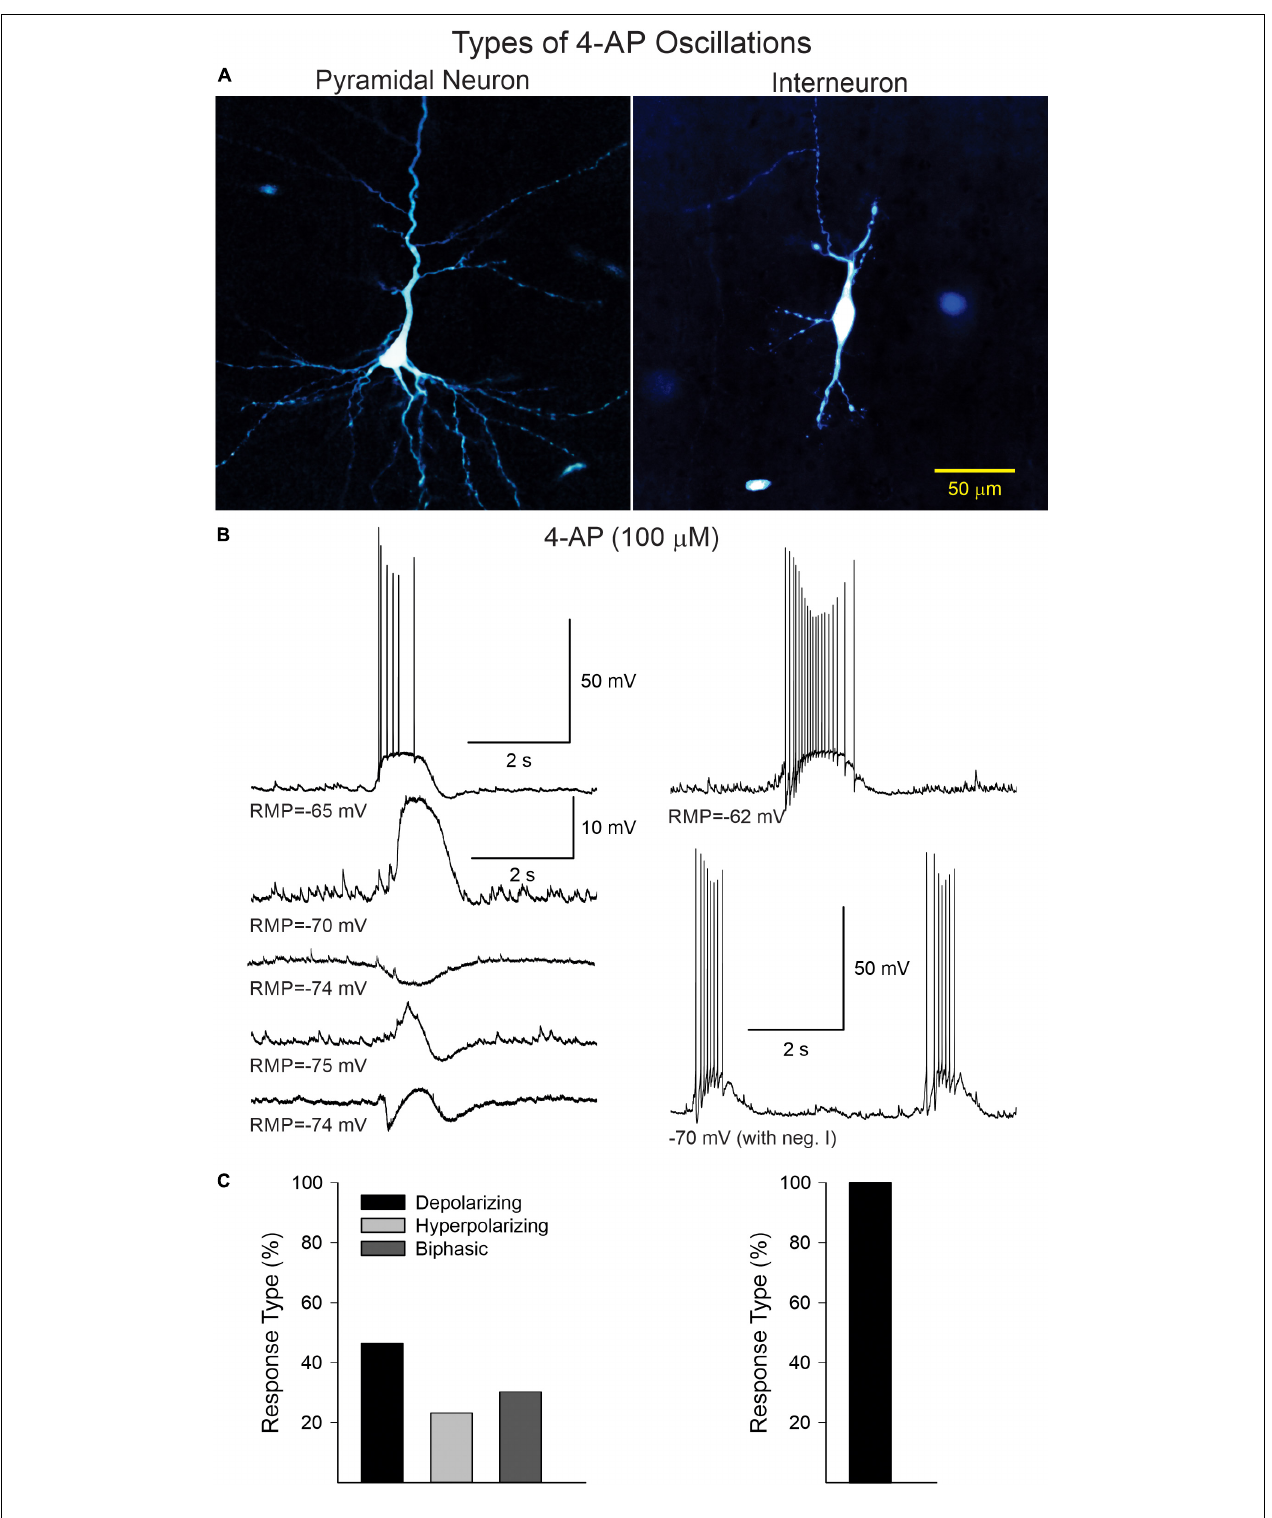
FIGURE 2 | (A) Examples of a CPN and an interneuron recorded and filled with biocytin. (B) Current clamp recordings illustrating the different types of 4-AP oscillations in CPNs and interneurons. In CPNs, 4-AP induced three main types of oscillations; most were depolarizing, with or without action potentials, some were mainly hyperpolarizing, and others were biphasic (depolarization followed by hyperpolarization or vice versa). In interneurons, 4-AP consistently induced membrane depolarizations accompanied by bursts of action potentials, even at hyperpolarized potentials (with negative current). (C) Bar graphs show the percentage of cells displaying the different types of oscillations in CPNs and